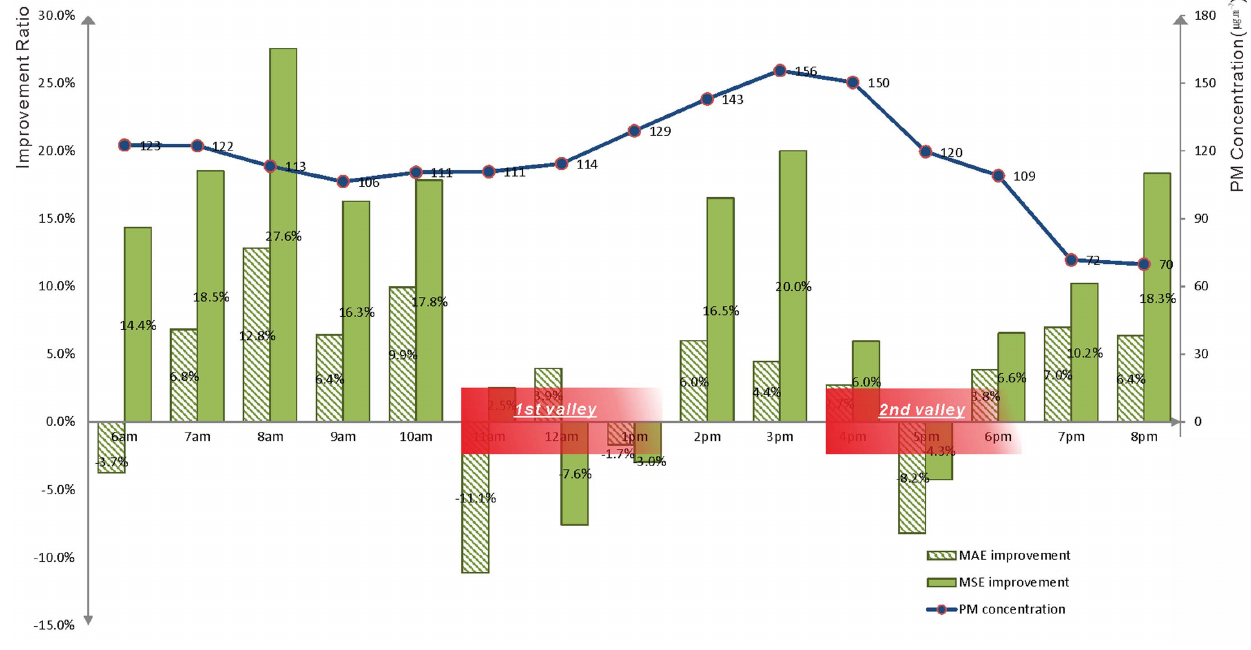
Figure 5. Temporal variation in the hourly PM 2.5 concentration and the improvement ratio of IDWS with respect to IDWE on May 26 th .